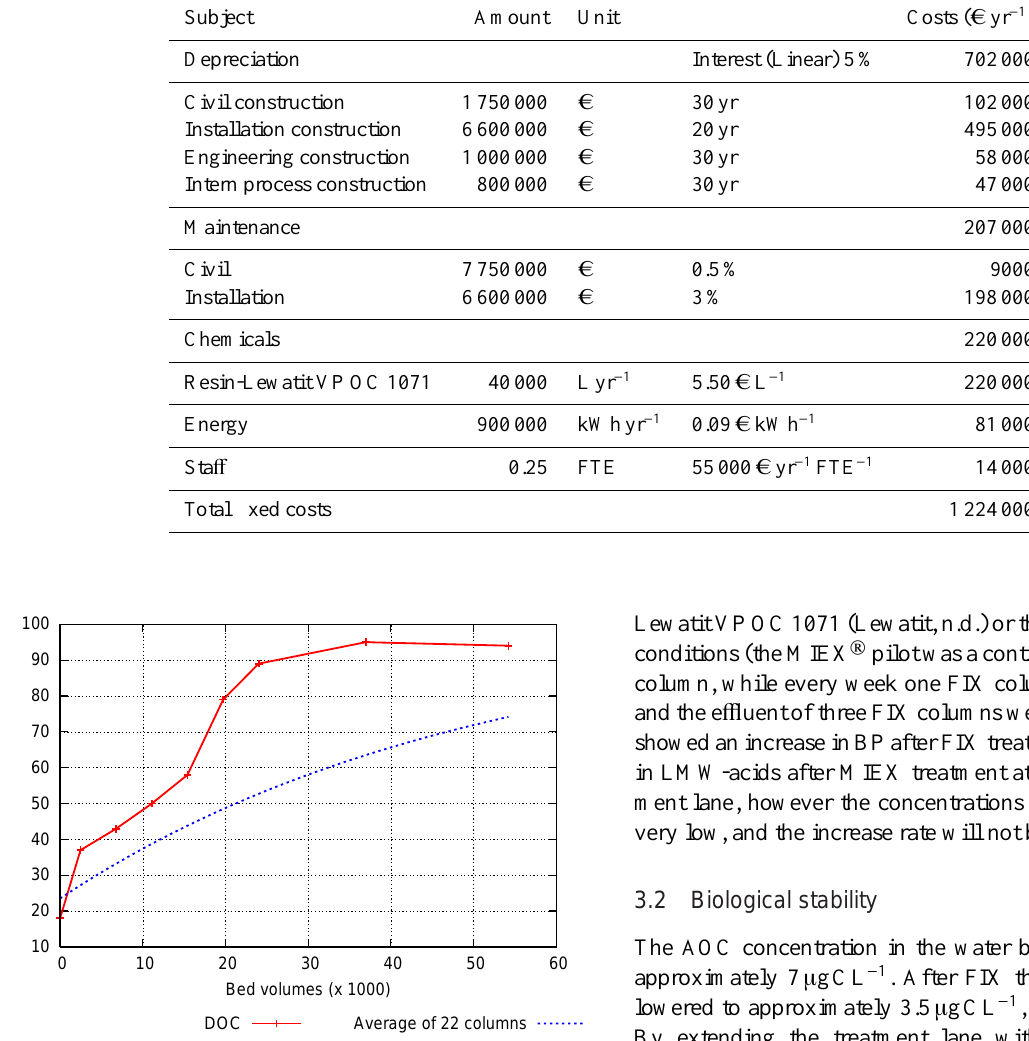
Figure 1: Breakthrough of one FIX column (positioned before ozonation in Figure 1. Breakthrough of one FIX column (positioned be- the WPK treatment plant) and the average of 22 columns for a certain filter fore ozonation in the WPK treatment plant) and the average of run time (x-axis) 22 columns for a certain filter run time